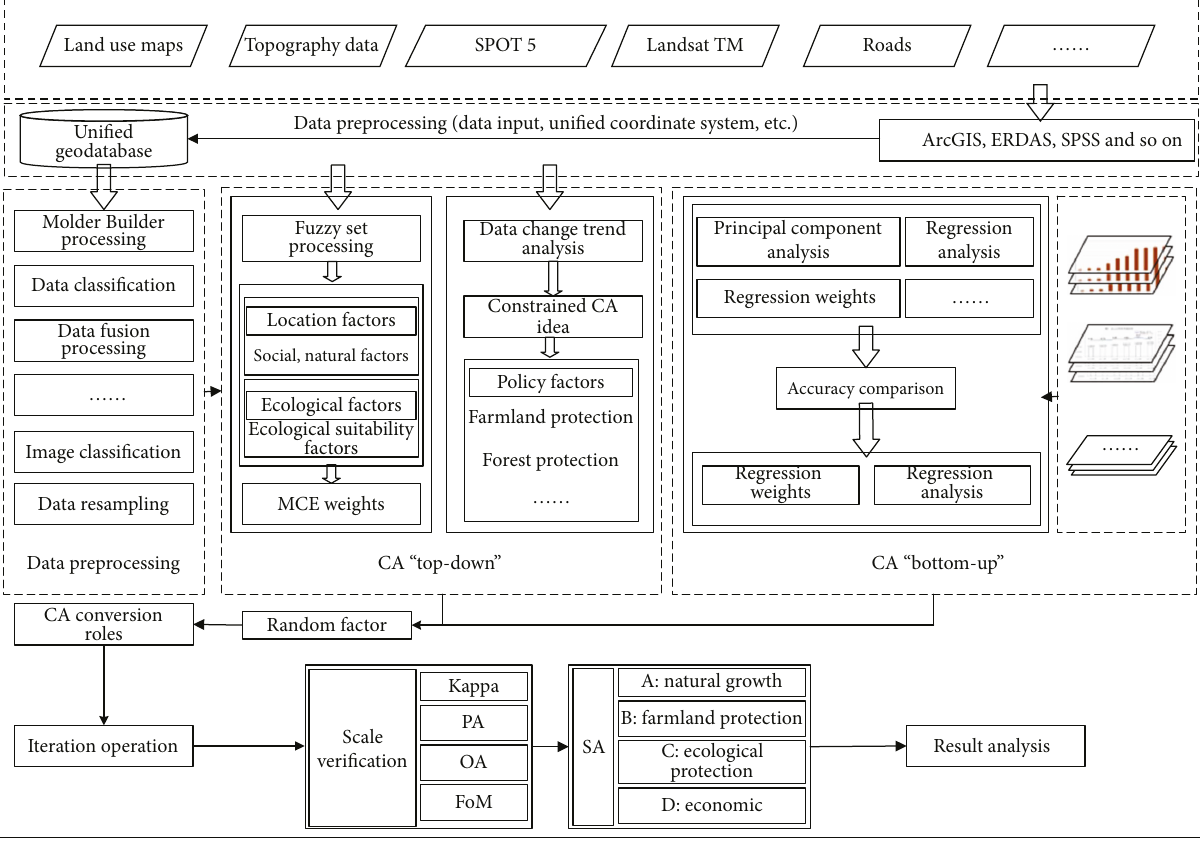
Figure 3: Cellular automata land use simulation based on the fuzzy set technology roadmap.